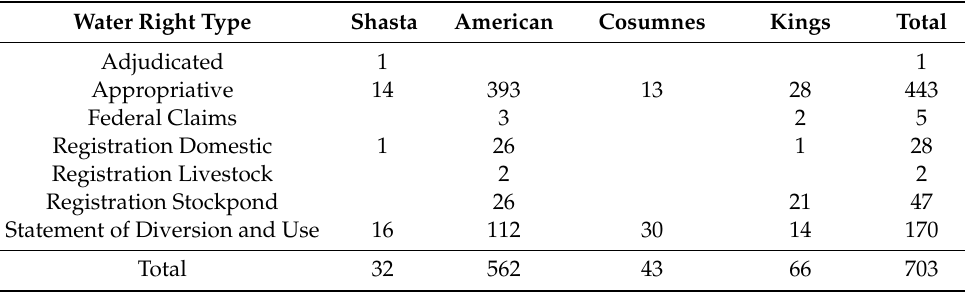
Table 4. Count of water rights by